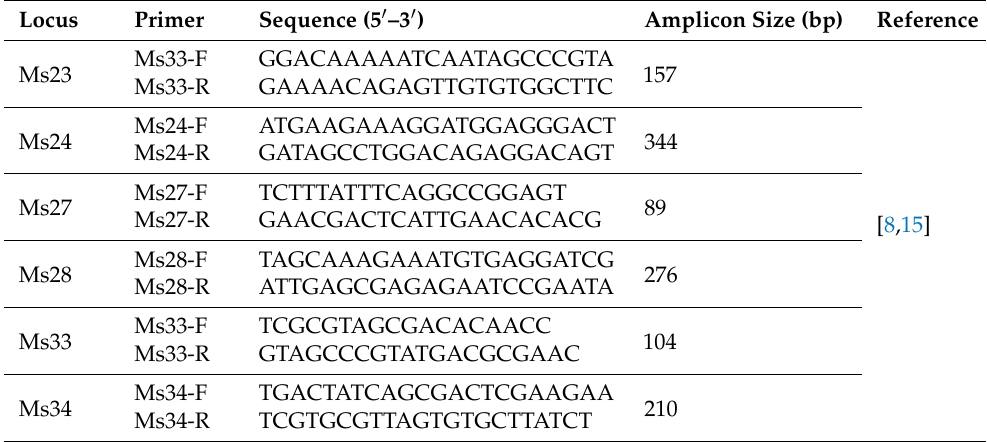
Table 1. Primers used for multiple locus variable-number tandem-repeat analysis (MLVA).